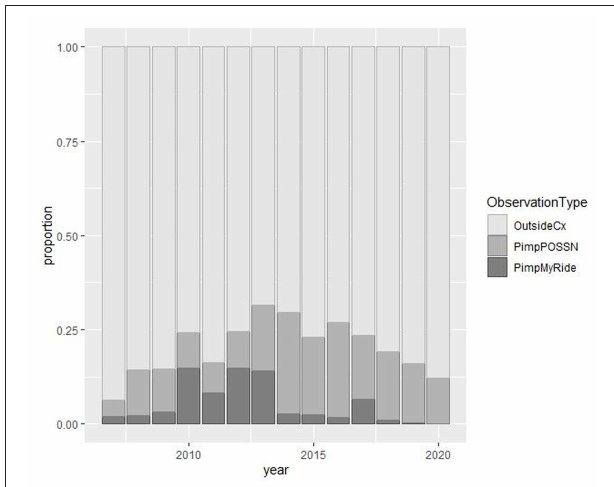
FIGURE 1 | Observation type per